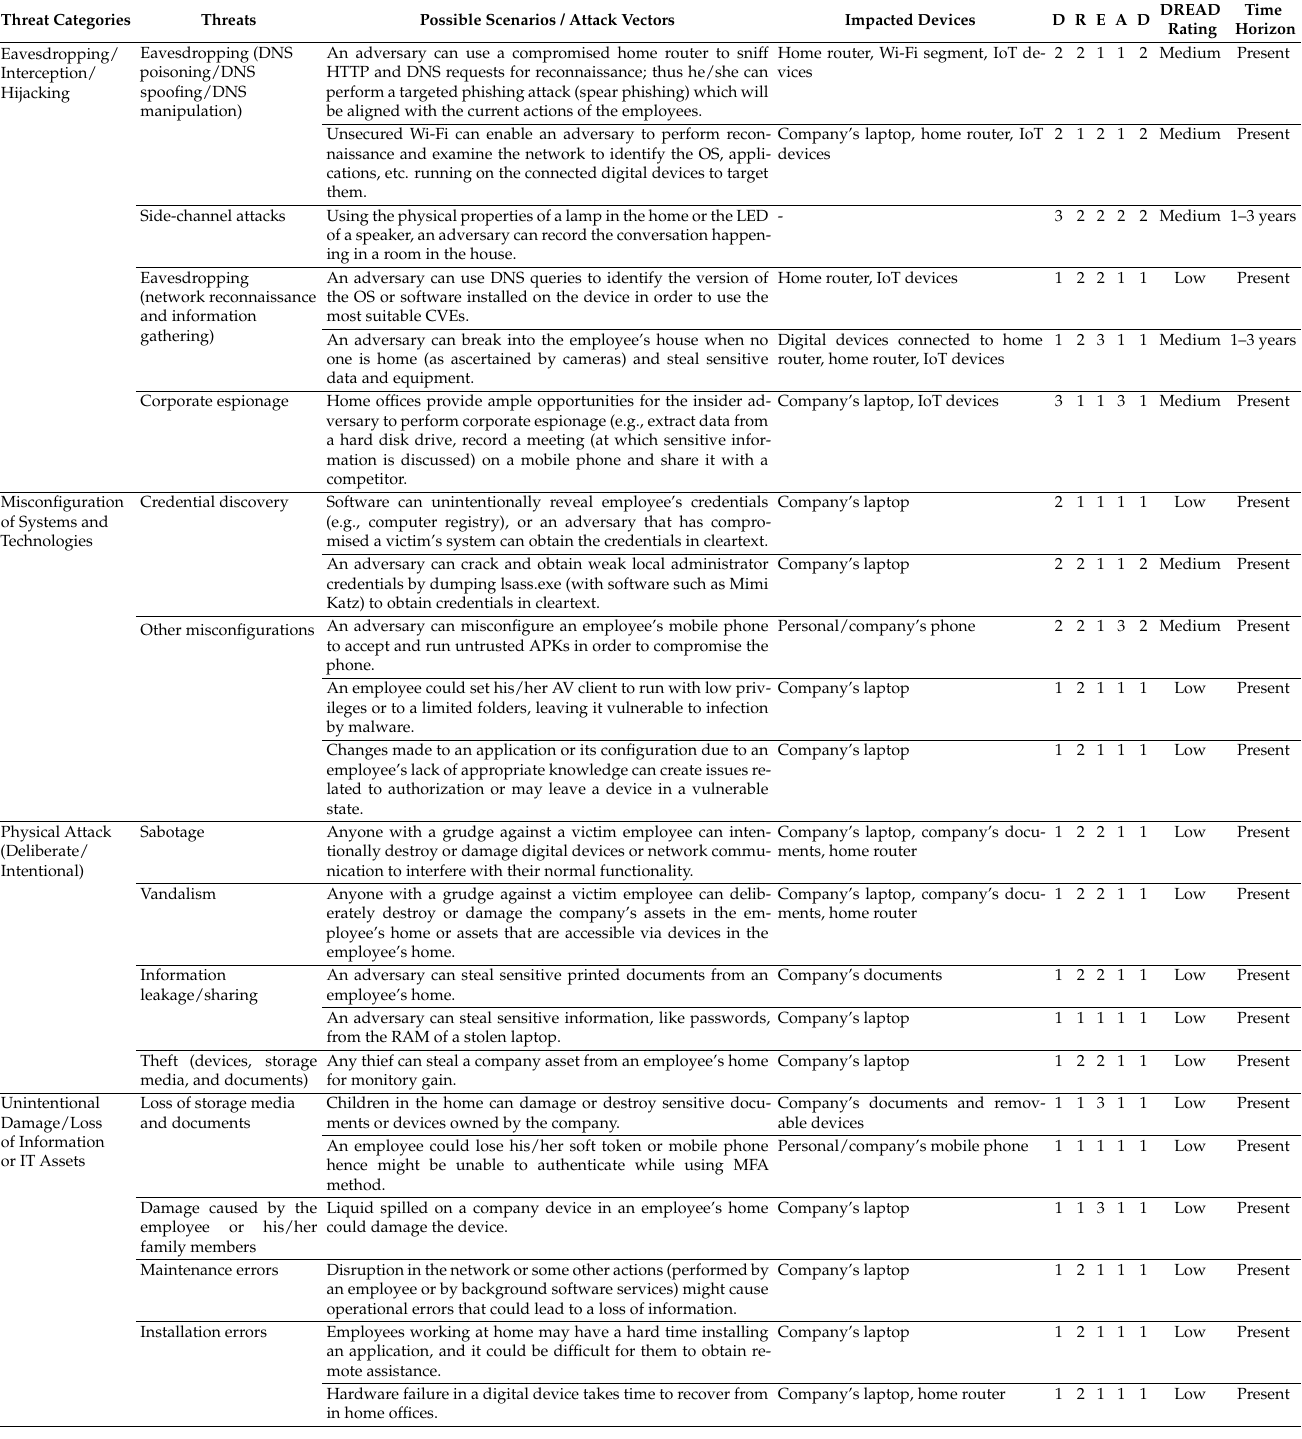
Table A3. Low-priority threats and use